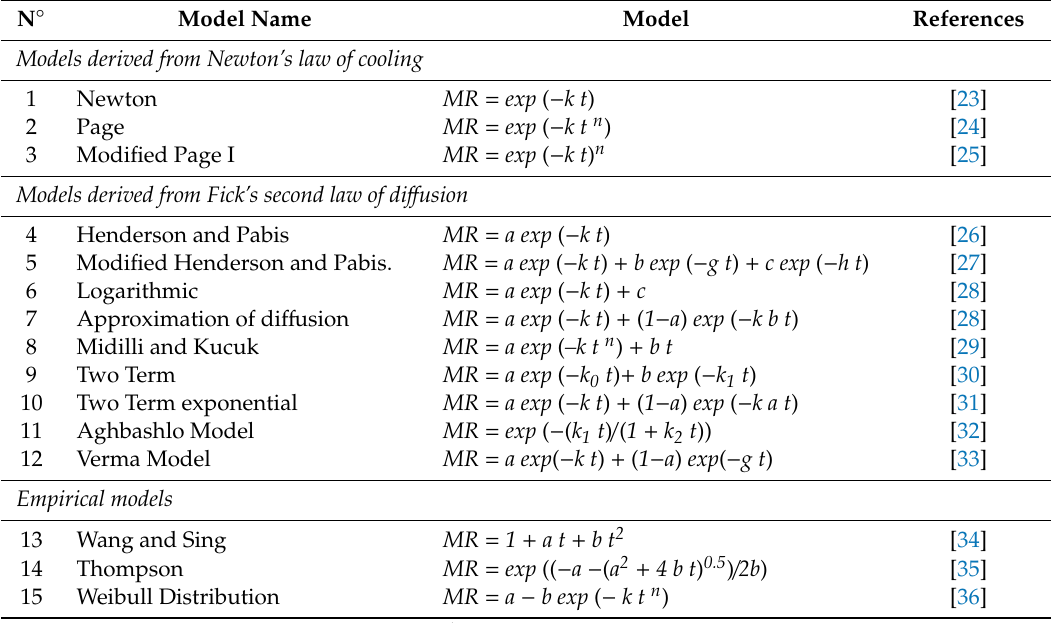
Table 1. Mathematical models applied to the drying